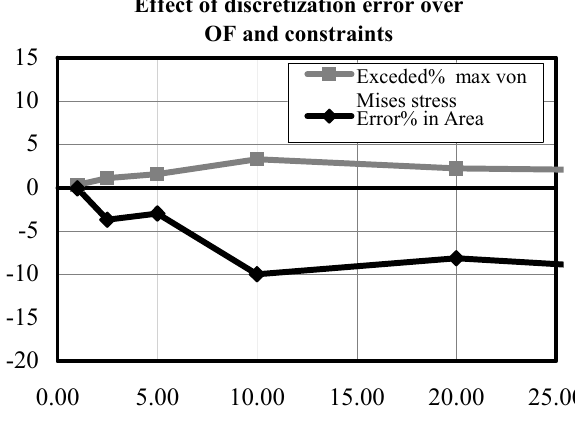
Fig. 10. Deterministic algorithm. Influence of γ over the accuracy of the objective function and the degree of satis- faction of stress constraint